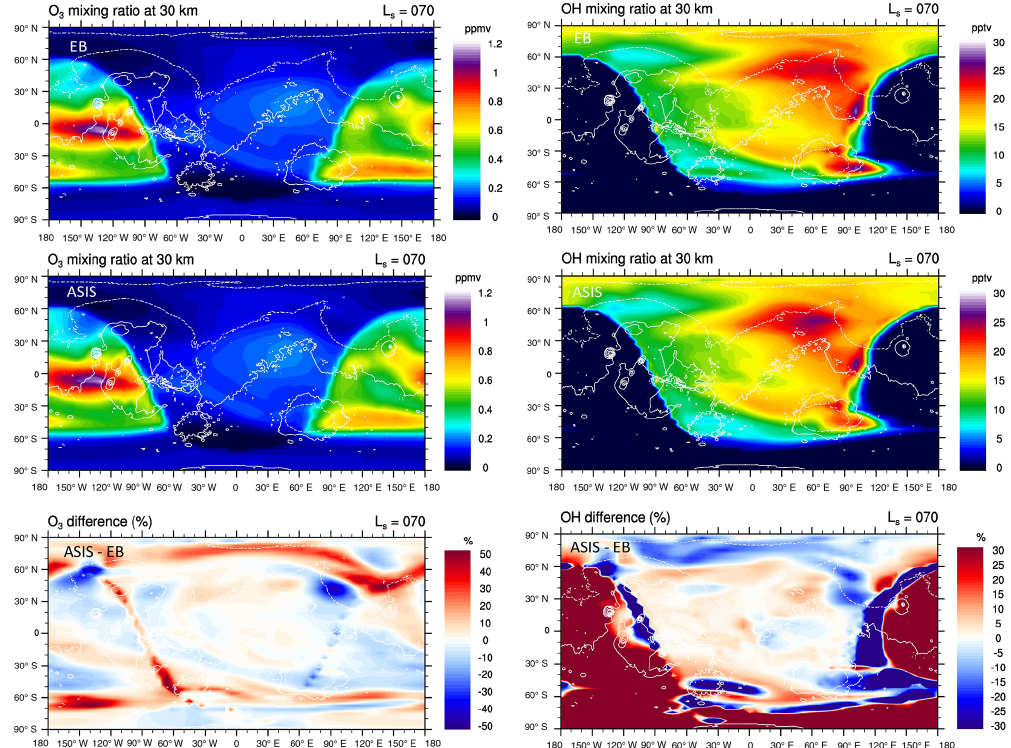
Figure 11. Distribution of O 3 (left) and OH (right) at 30km calculated by the LMD Mars GCM in northern spring (instantaneous result at solar longitude Ls = 70 ◦ and day 150 of the simulation). Top: Euler-backward (EB) solver. Middle: ASIS solver. Bottom: relative difference (%) between ASIS and EB, using thresholds of 10ppbv for O 3 and 10pptv for OH. Local noon is located at longitude zero. The white contour represents topography, with a 4km interval. Off-scale differences in O 3 and OH are limited to ± 50% and ± 30%